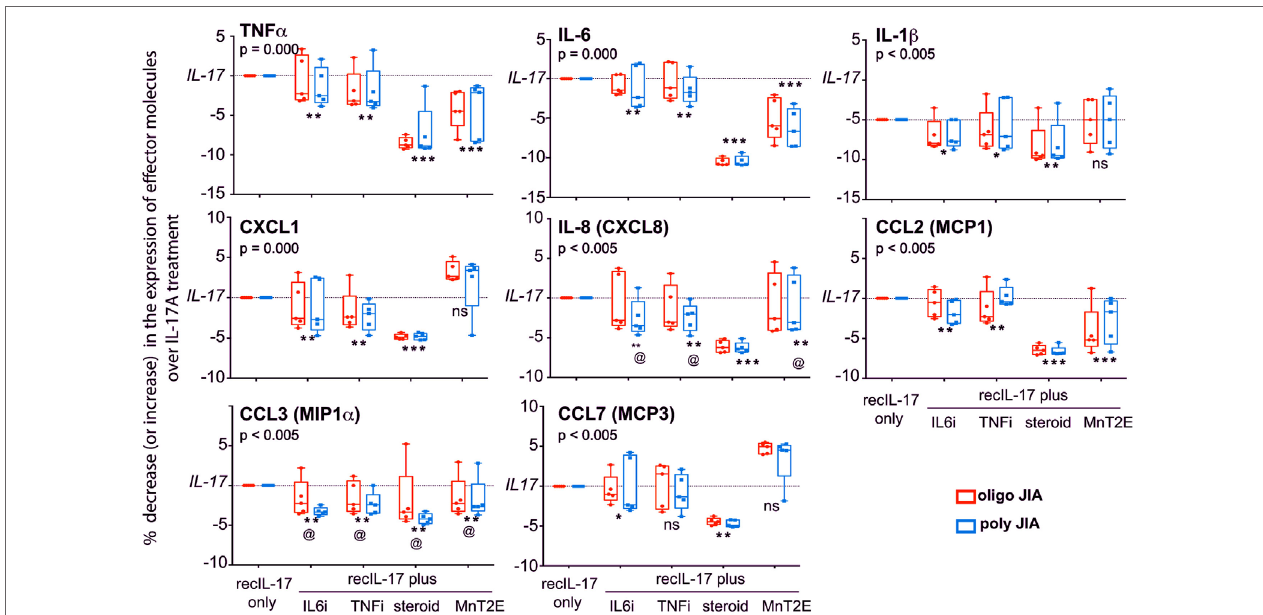
FigUre 8 | IL-17A-mediated production of cytokines and chemokines by FLC, and their sensitivity to MnT2E. Data shown are box-median-whisker plots ( n = 5–7 per group), which were constructed as in Figure 1 . As depicted, the maximum levels of production of each of the indicated molecules by FLC cultures in 200 ng/ml recombinant IL-17A [recIL-17] were set as 100% response. Production levels of each indicated molecular effector in FLC cultures with recIL-17 combined with 5 µM corticosteroid or IL6i or TNFi, or 34 µM MnT2E were normalized as percent increase or decrease over the maximal response to recIL-17. The indicated P -values were determined by Kruskal–Wallis ANOVA. Post hoc group comparisons by Tukey: *** P < 0.005 indicate corticosteroid- and/or MnT2E-mediated suppression of IL-17A-mediated production of effectors was significantly greater than those elicited by TNFi or IL6i; [**] and [*] P < 0.01 and P < 0.05, respectively, indicate significant suppression of production of effector molecules compared recIL17 only group; [@] no significant differences among inhibitor-treated groups, but significantly different ( P < 0.05) from the recIL-17 only group; ns, not significantly different between the inhibitor-treated group(s) and recIL-17 only